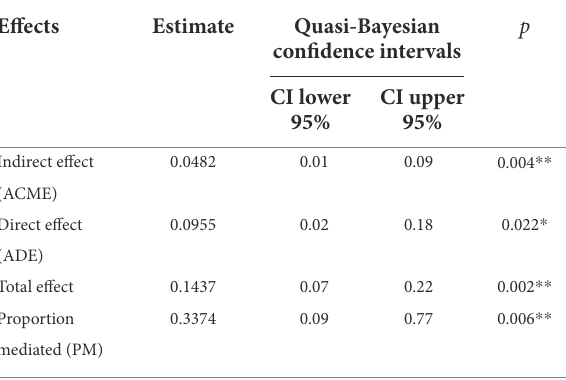
TABLE 4 Results of Bayesian mediation analysis.